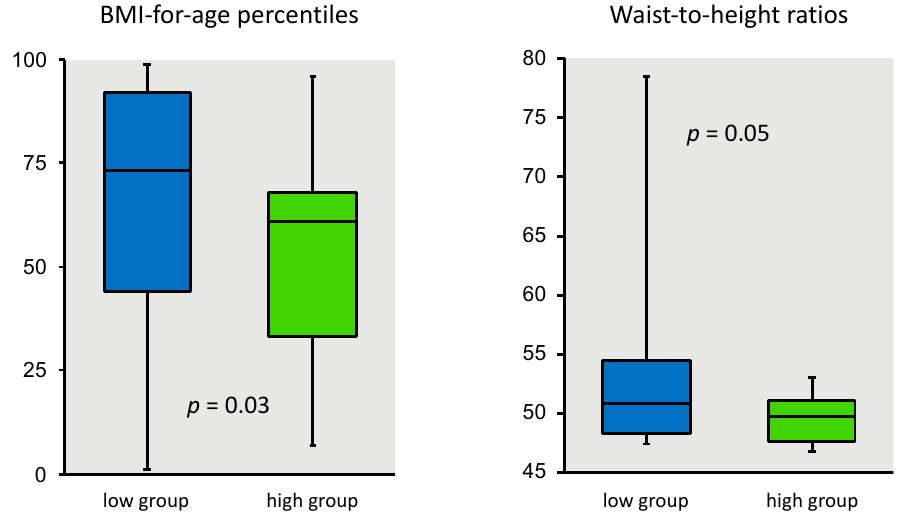
Figure 2. Niños Sanos Obesity Risk Assessment, final version with 18 items, tailored to Spanish speaking immigrant parents of 2–5 year old children. Printed in color on one 11 by 17-inch paper, folded in booklet format.